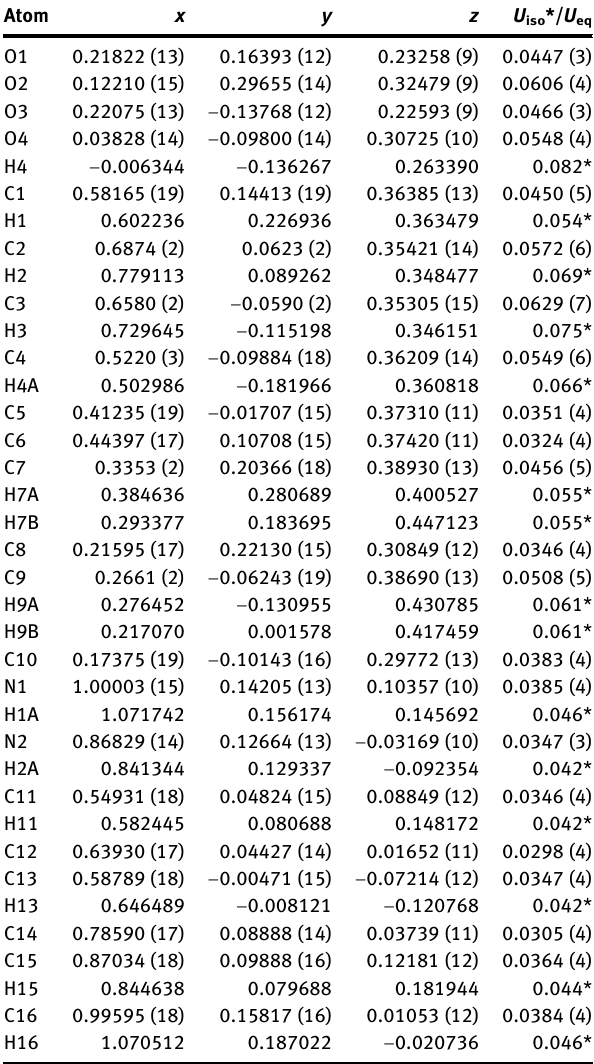
Table  : Fractional atomic coordinates and isotropic or equivalent isotropic displacement parameters (Å 